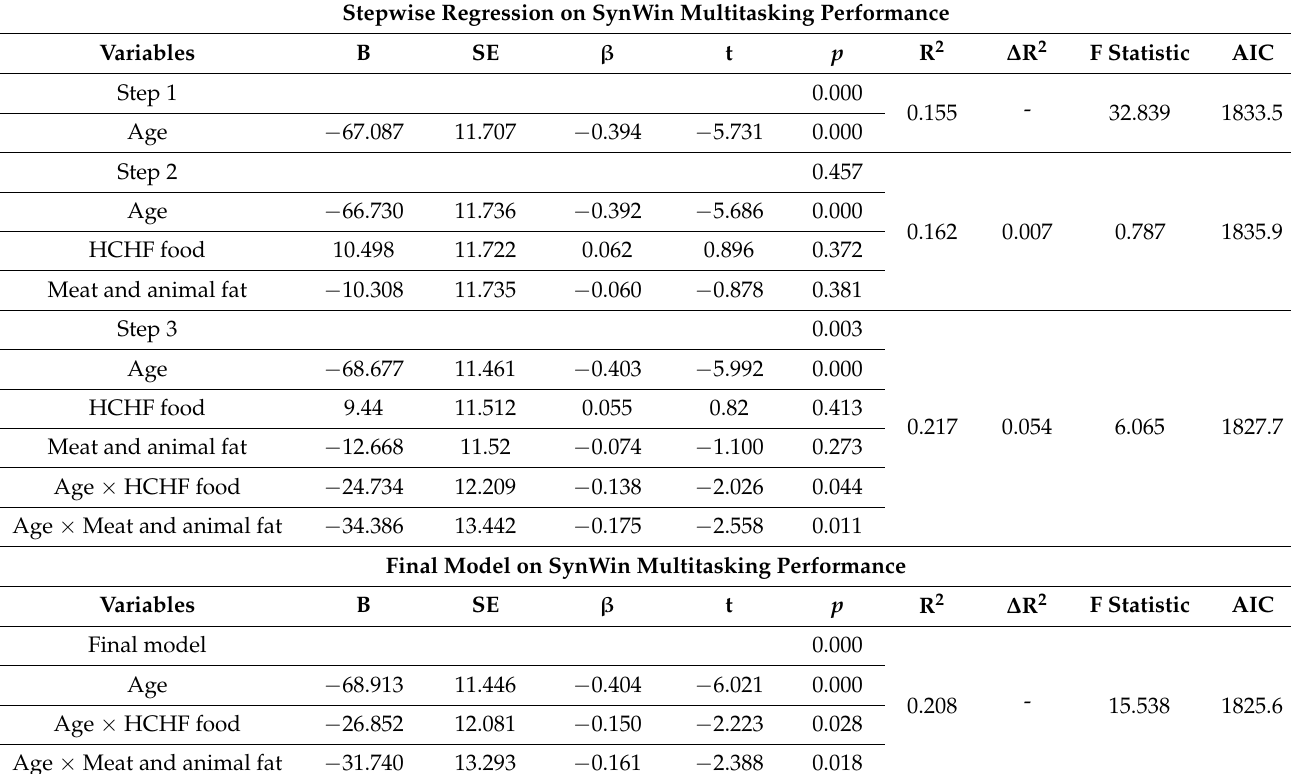
Table 5. Summary of linear stepwise regression analysis for various consumption patterns predicting SynWin multitasking performance in the group of all participants ( n = 181).